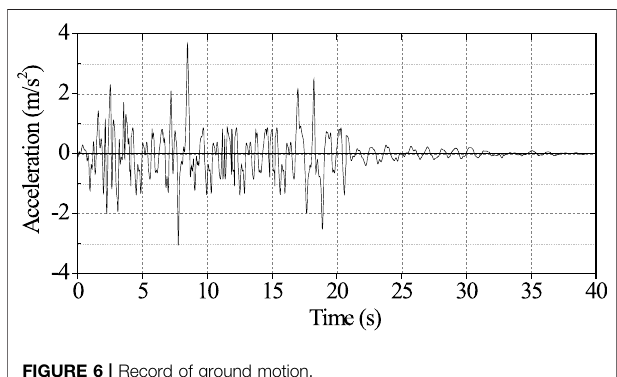
FIGURE 6 | Record of ground motion.